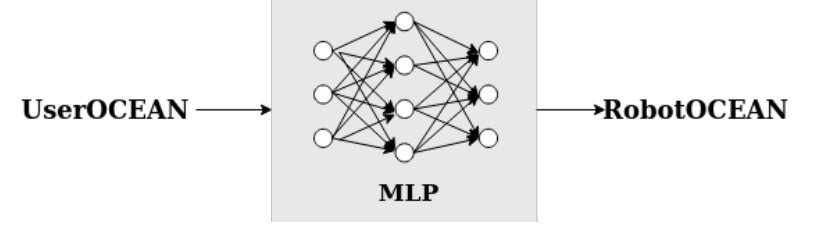
Figure 8. Module 02- responsible for inferring the robot’s personality.